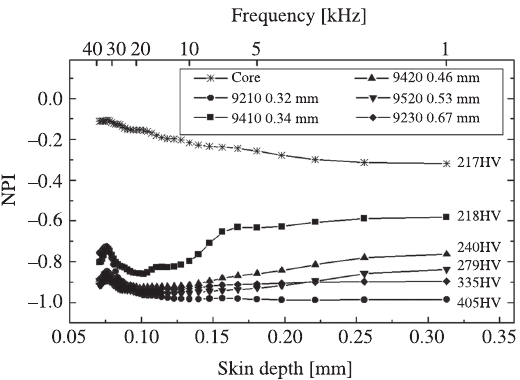
Figure 5. Normalized power index NPI vs frequency for several samples calculated from FFTs. The bottom scale (skin depth) relates the frequency dependent NPI to distance through the skin depth equation. Upper legend gives sample number and l the various curves. Numbers to the right of the curves are Vickers hardness